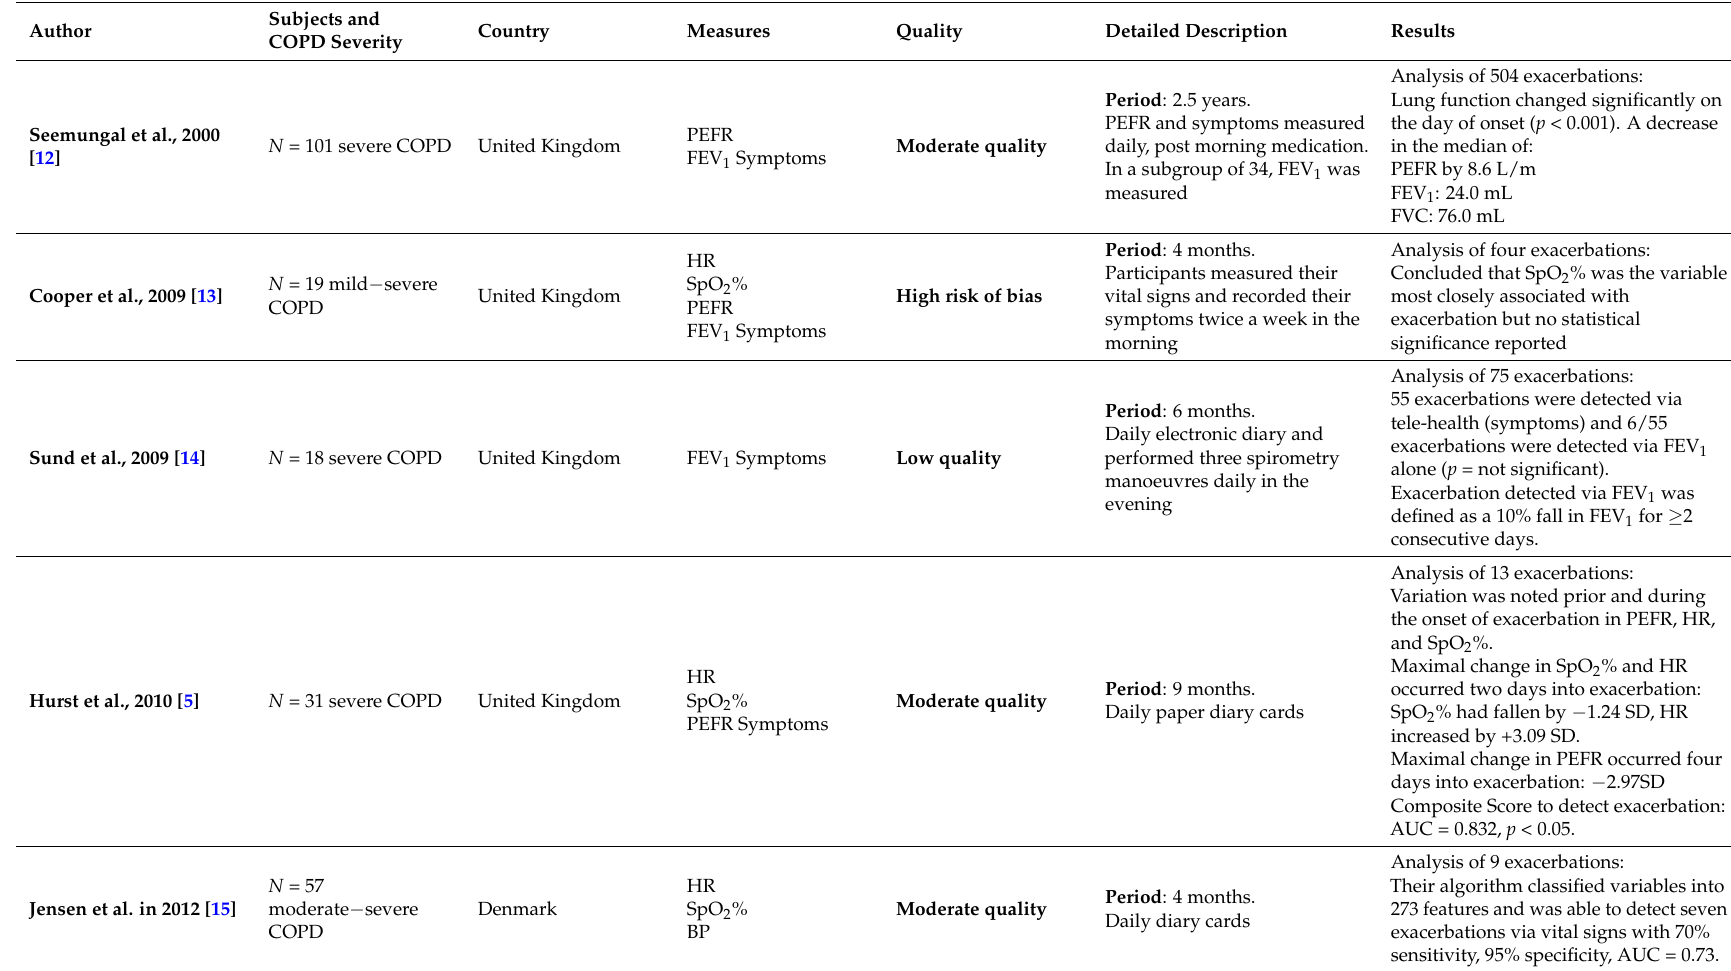
Table 1. Detailed description of the 16 included